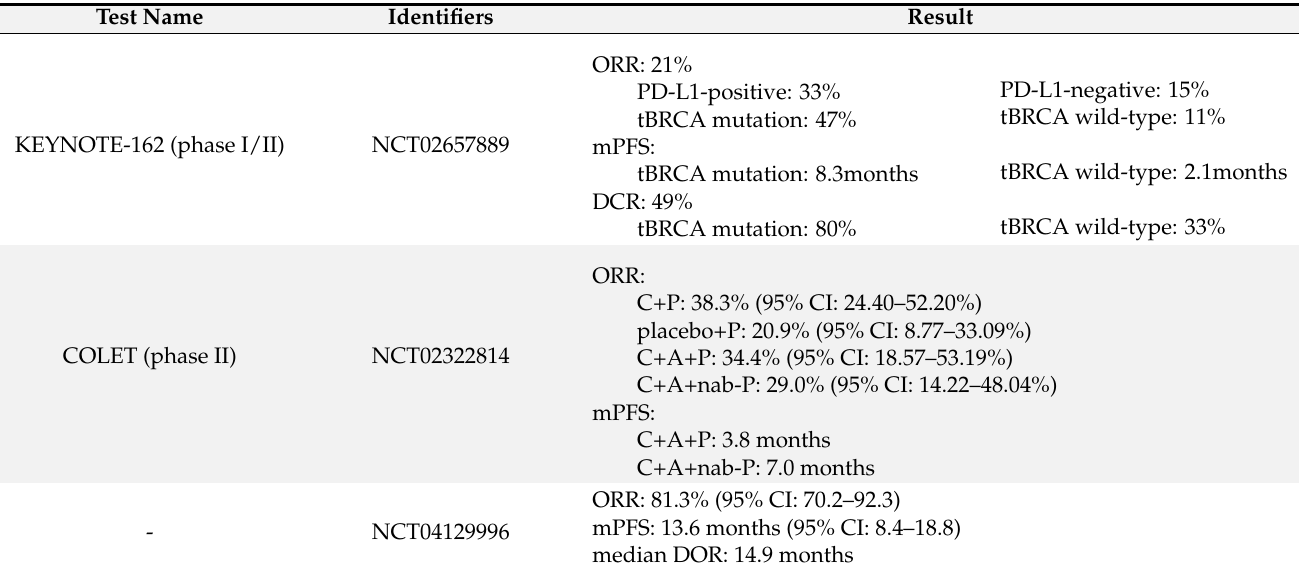
Table 6. Clinical trial results for PD-1/PD-L1 inhibitors in combination with small molecule inhibitors.